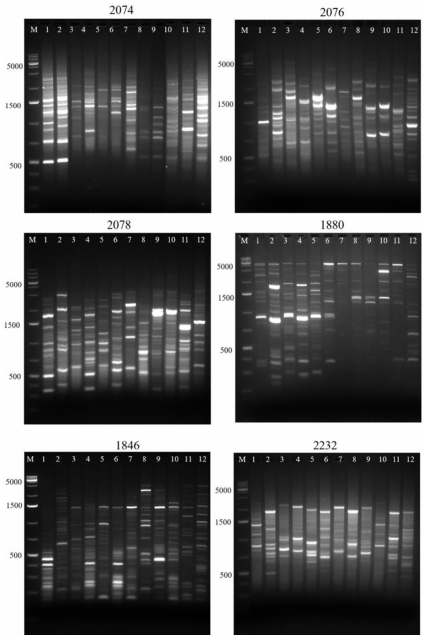
Figure 2. Inter-primer binding site (iPBS) based fingerprinting of B. veronicifolia (iPBS 2074, 2076, 2078, 1880, 1846 and 2232) (M = Molecular weight; 1–12 samples of Guanajuato